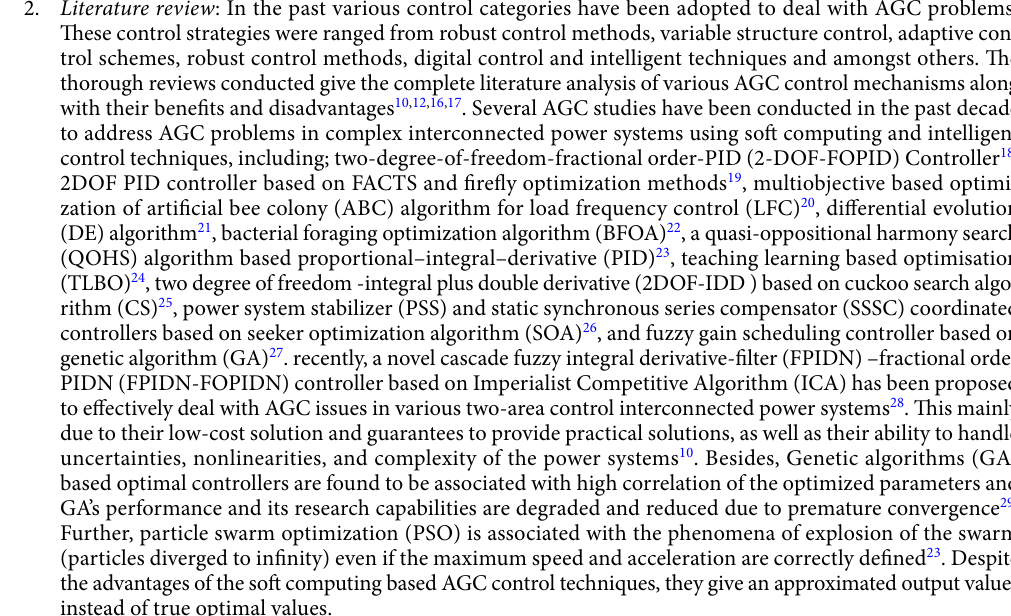
(DE) algorithm 21 , bacterial foraging optimization algorithm (BFOA) 22 , a quasi-oppositional harmony search (QOHS) algorithm based proportional–integral–derivative (PID) 23 , teaching learning based optimisation (TLBO) 24 , two degree of freedom -integral plus double derivative (2DOF-IDD ) based on cuckoo search algo- rithm (CS) 25 , power system stabilizer (PSS) and static synchronous series compensator (SSSC) coordinated controllers based on seeker optimization algorithm (SOA) 26 , and fuzzy gain scheduling controller based on genetic algorithm (GA) 27 . recently, a novel cascade fuzzy integral derivative-filter (FPIDN) –fractional